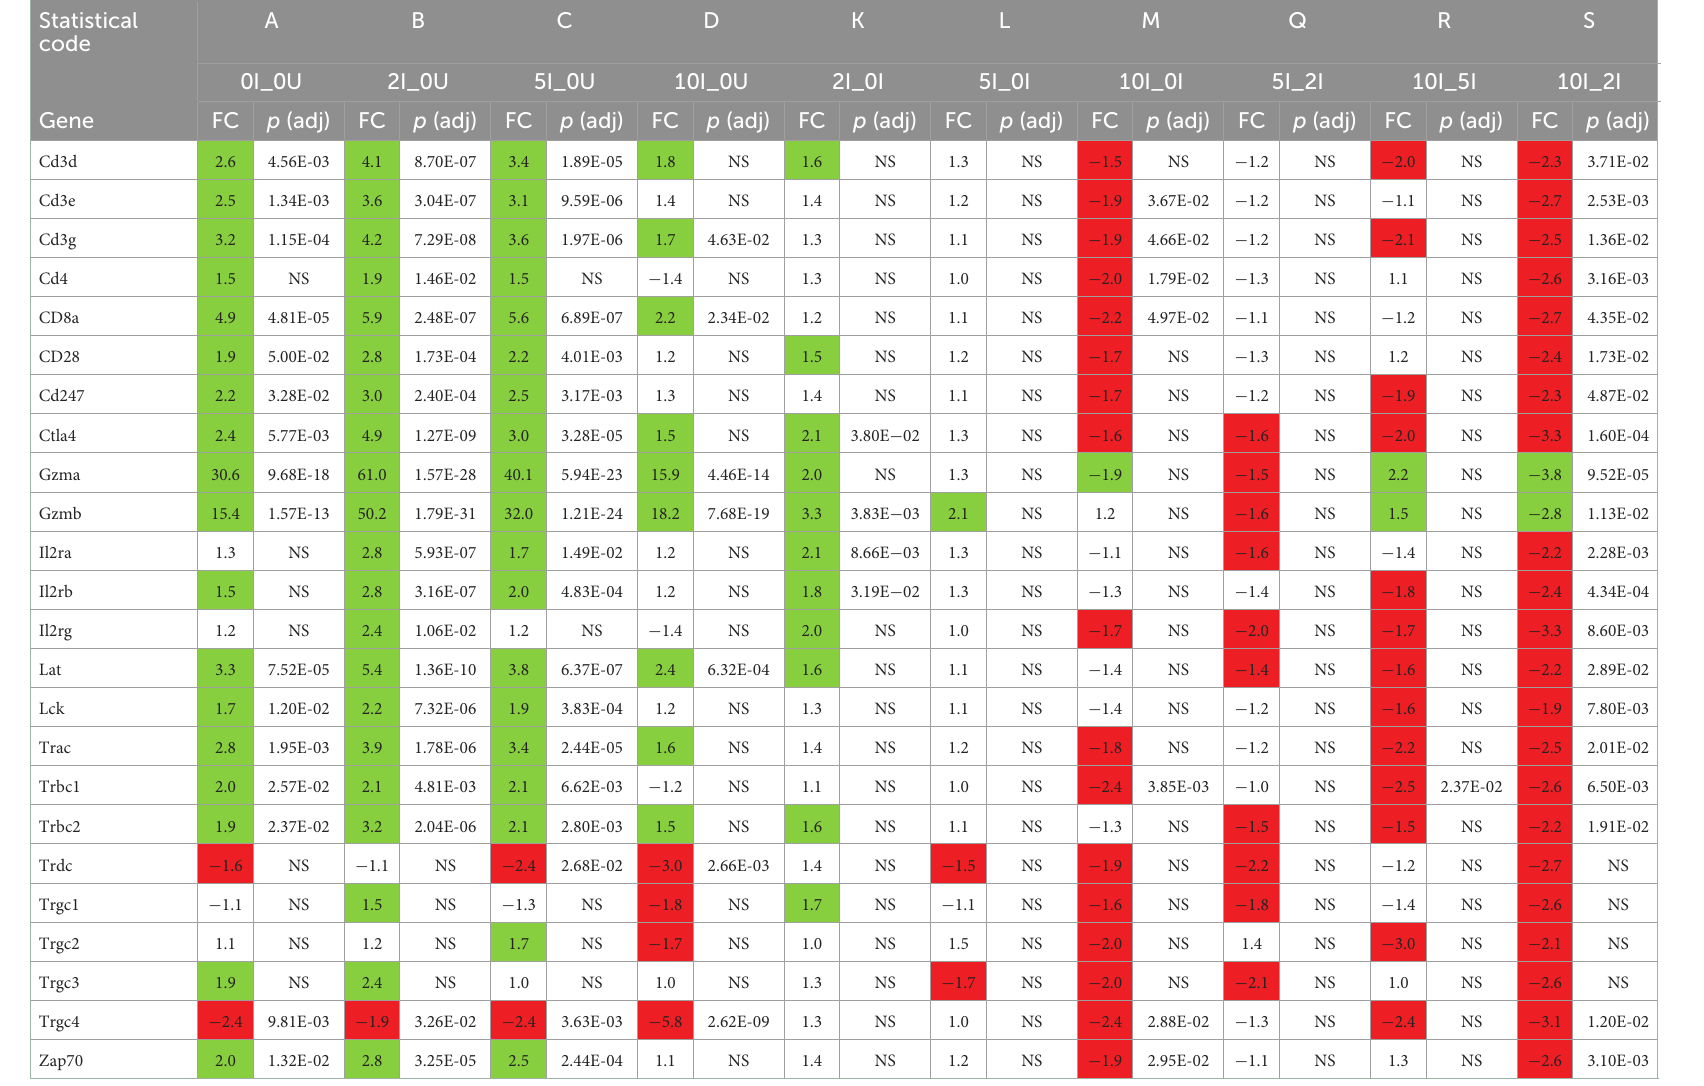
TABLE 7 Differentially expressed T-cell associated genes in the distal colon. Statistical